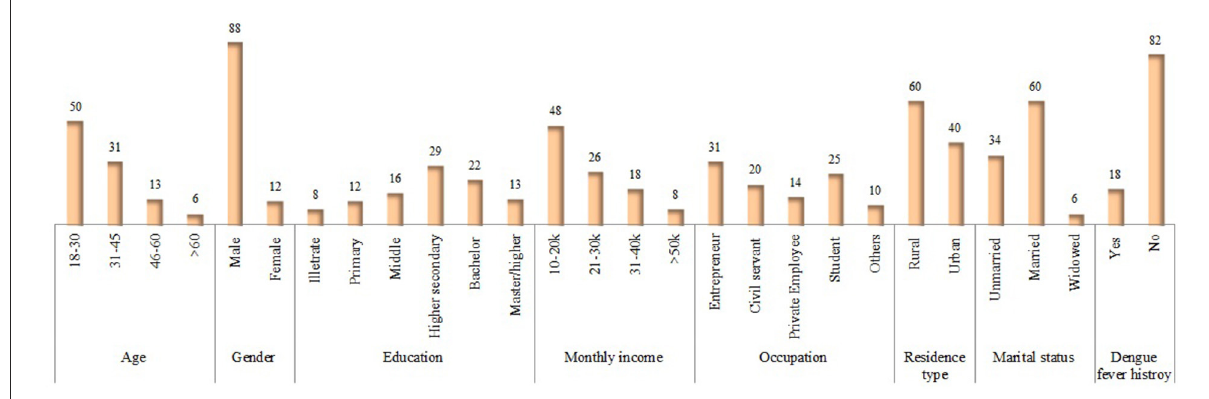
FIGURE5 Socio-demographic characteristics of KAP-study participants in Phase II. Values are presented: n (%).